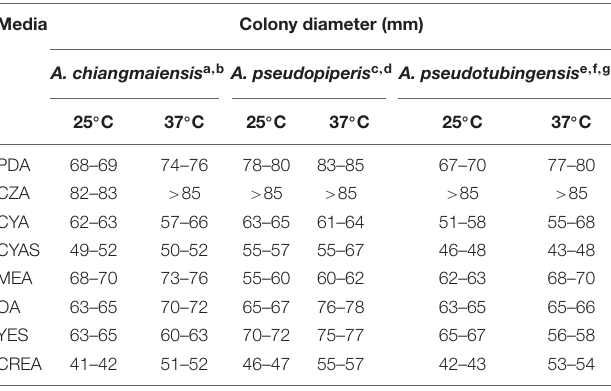
TABLE 2 | Colony diameter of seven fungal strains in this study on different media at 25 and 37 ◦ C after 7 days of incubation in the darkness.